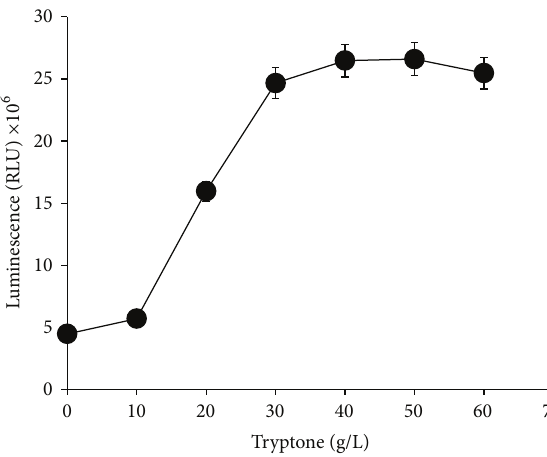
Figure 5: Effects of different tryptone concentrations on biolu- minescence production of Photobacterium sp. strain MIE. The cultures were grown in luminescence media containing different concentrations of tryptone and incubated in an orbital shaker (100rpm)for12hoursatroomtemperature.Dataismean ± standard error of the mean ( 𝑛 = 3 ).